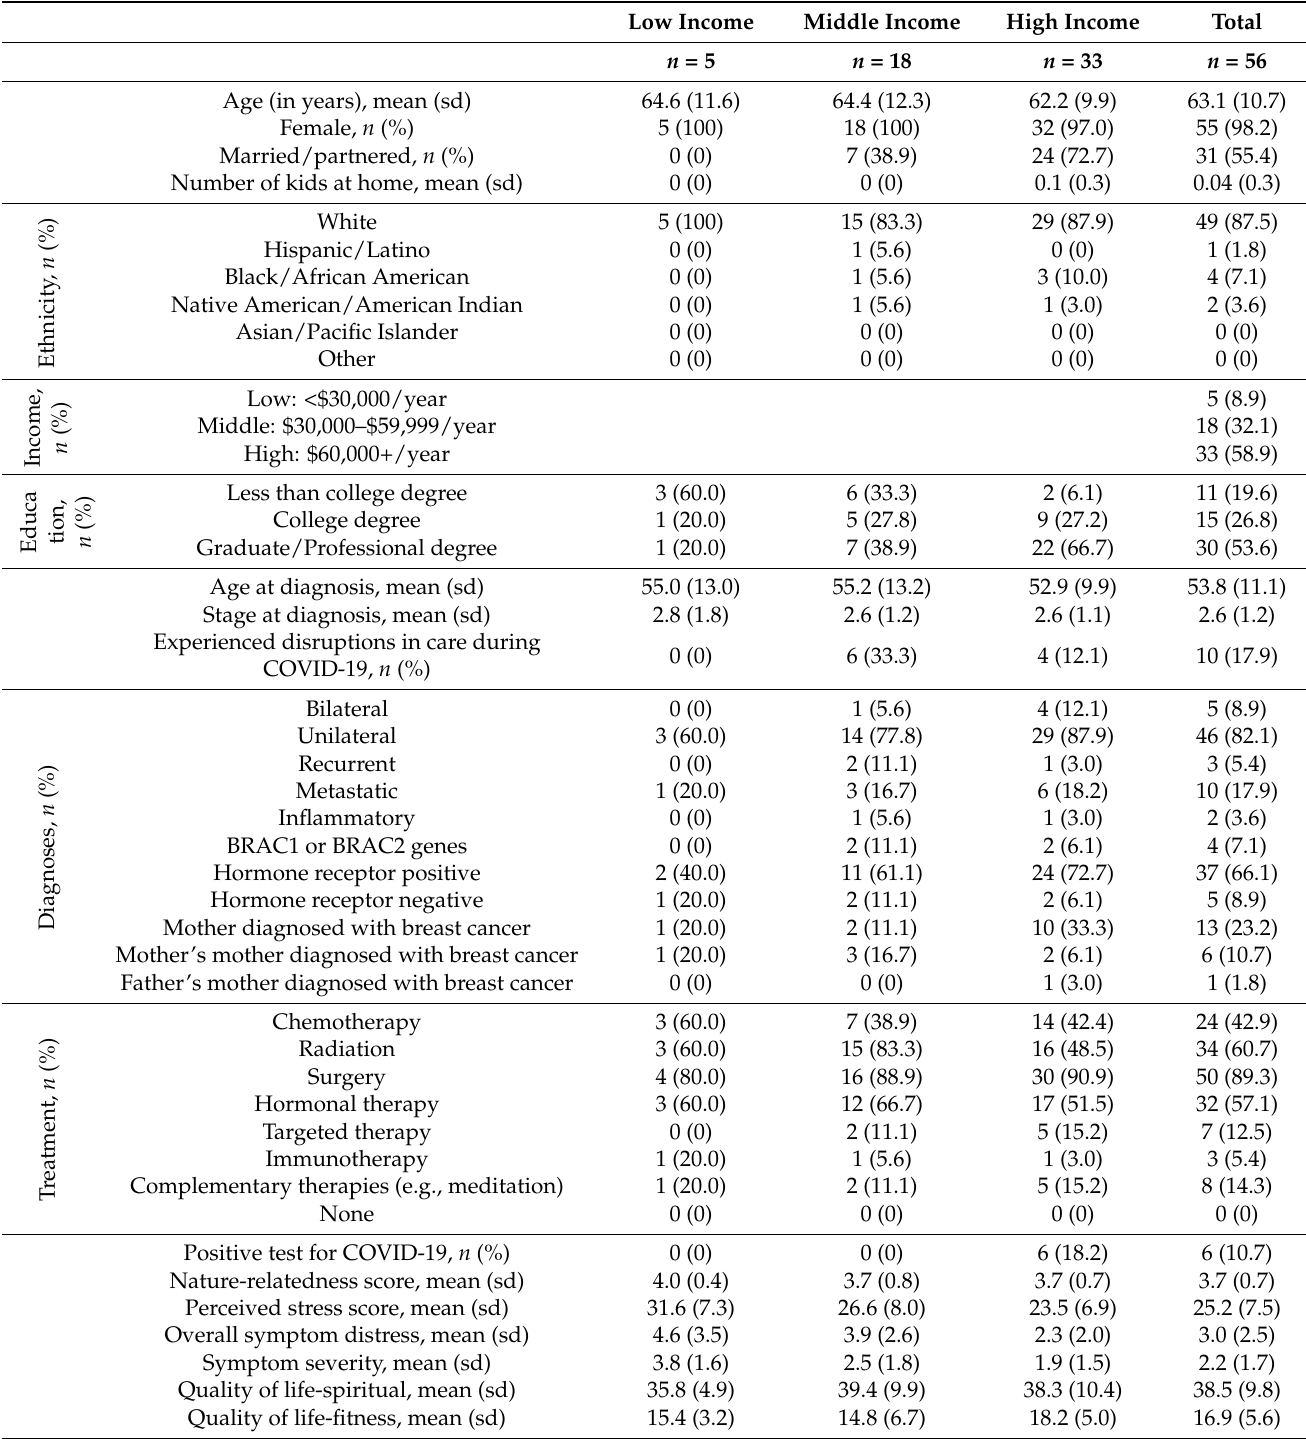
Table 1. Demographic and health